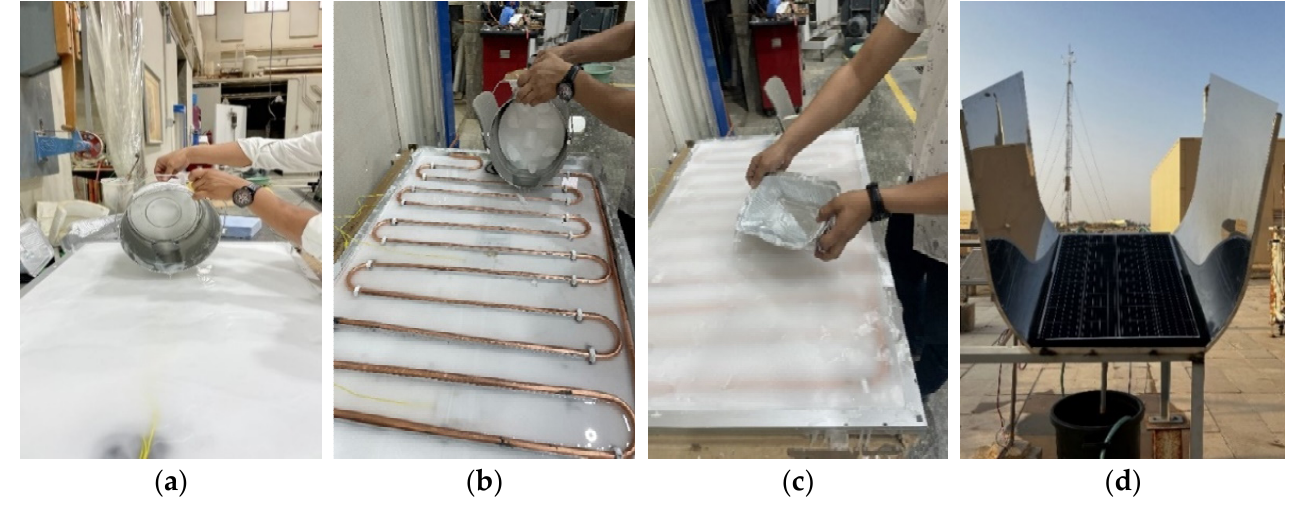
Figure 4. Pictorial views of equipping the PV panels with PCM and LCPV: ( a ) PV2, ( b ) PV3, ( c ) PV4, and ( d ) PV4 with low-concentrator.